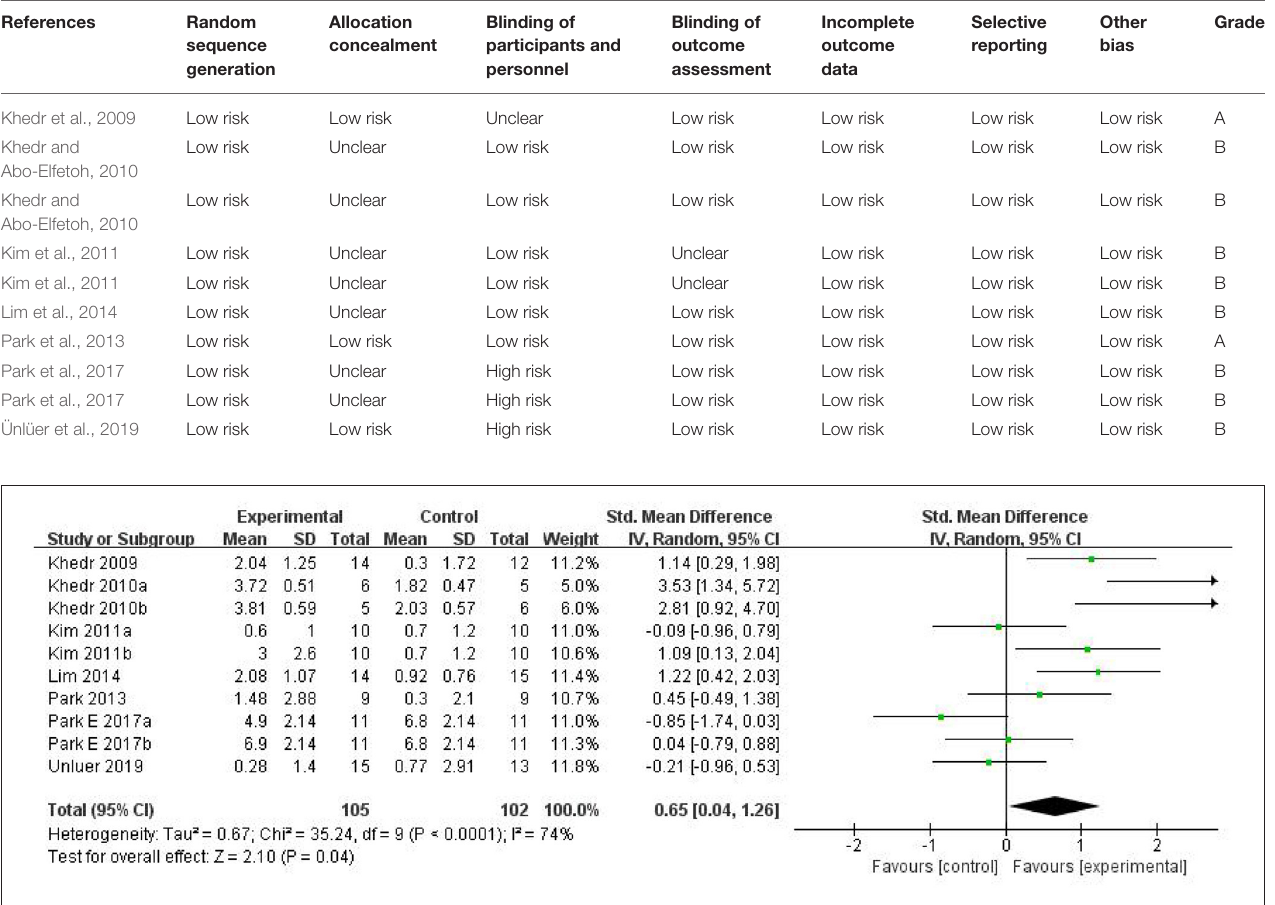
FIGURE 4 | The effects of rTMS on deglutition